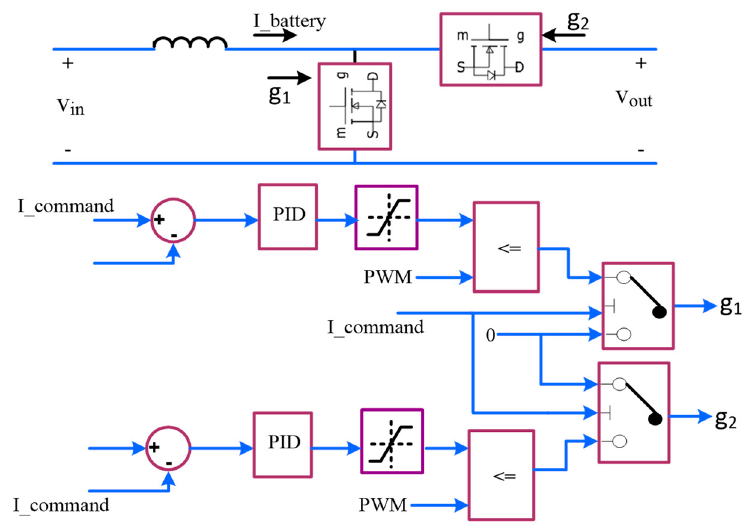
Figure 9. Bidirectional DC/DC converter model.